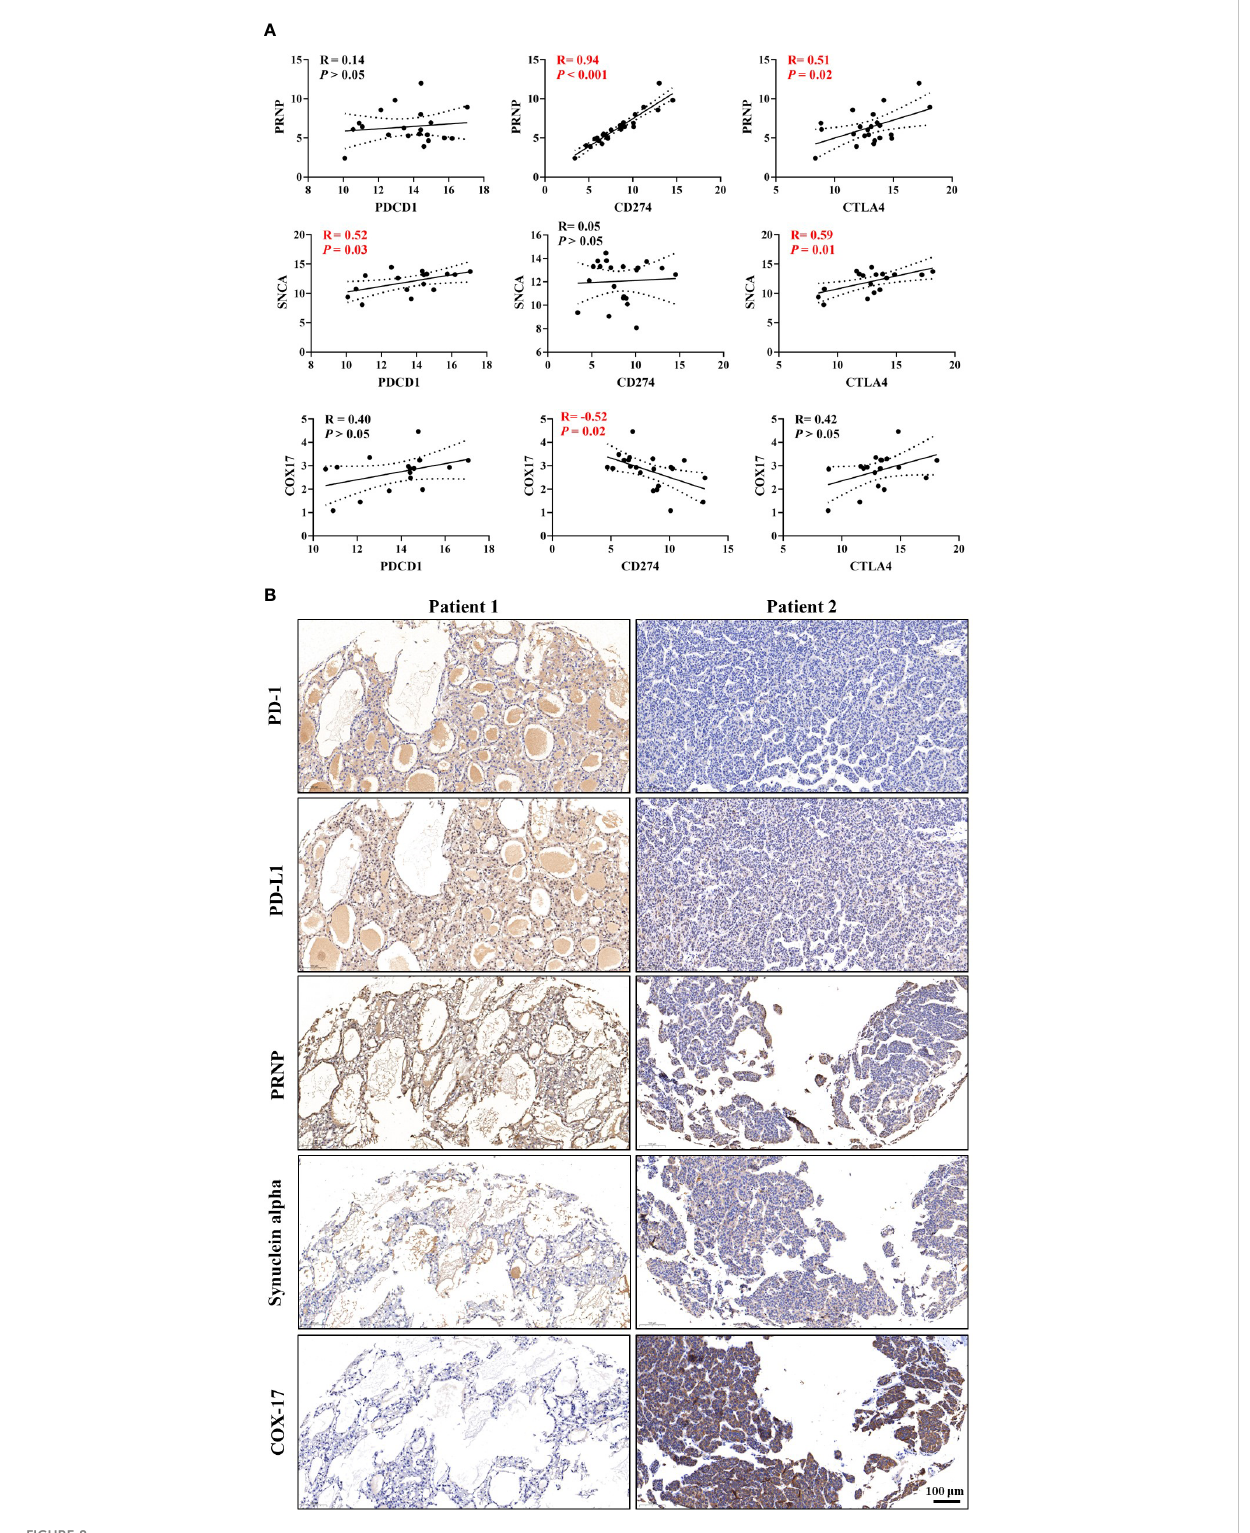
FIGURE 8 Validation of correlations among cuproptosis-related genes (CRGs), tumor immune microenvironment (TIM), and immune checkpoint genes (ICGs) in the Renji cohort. (A) Correlation analyses between CRGs and ICGs. (B) Immunohistochemical (IHC) staining of CRGs and ICGs in hepatocellular carcinoma (HCC)